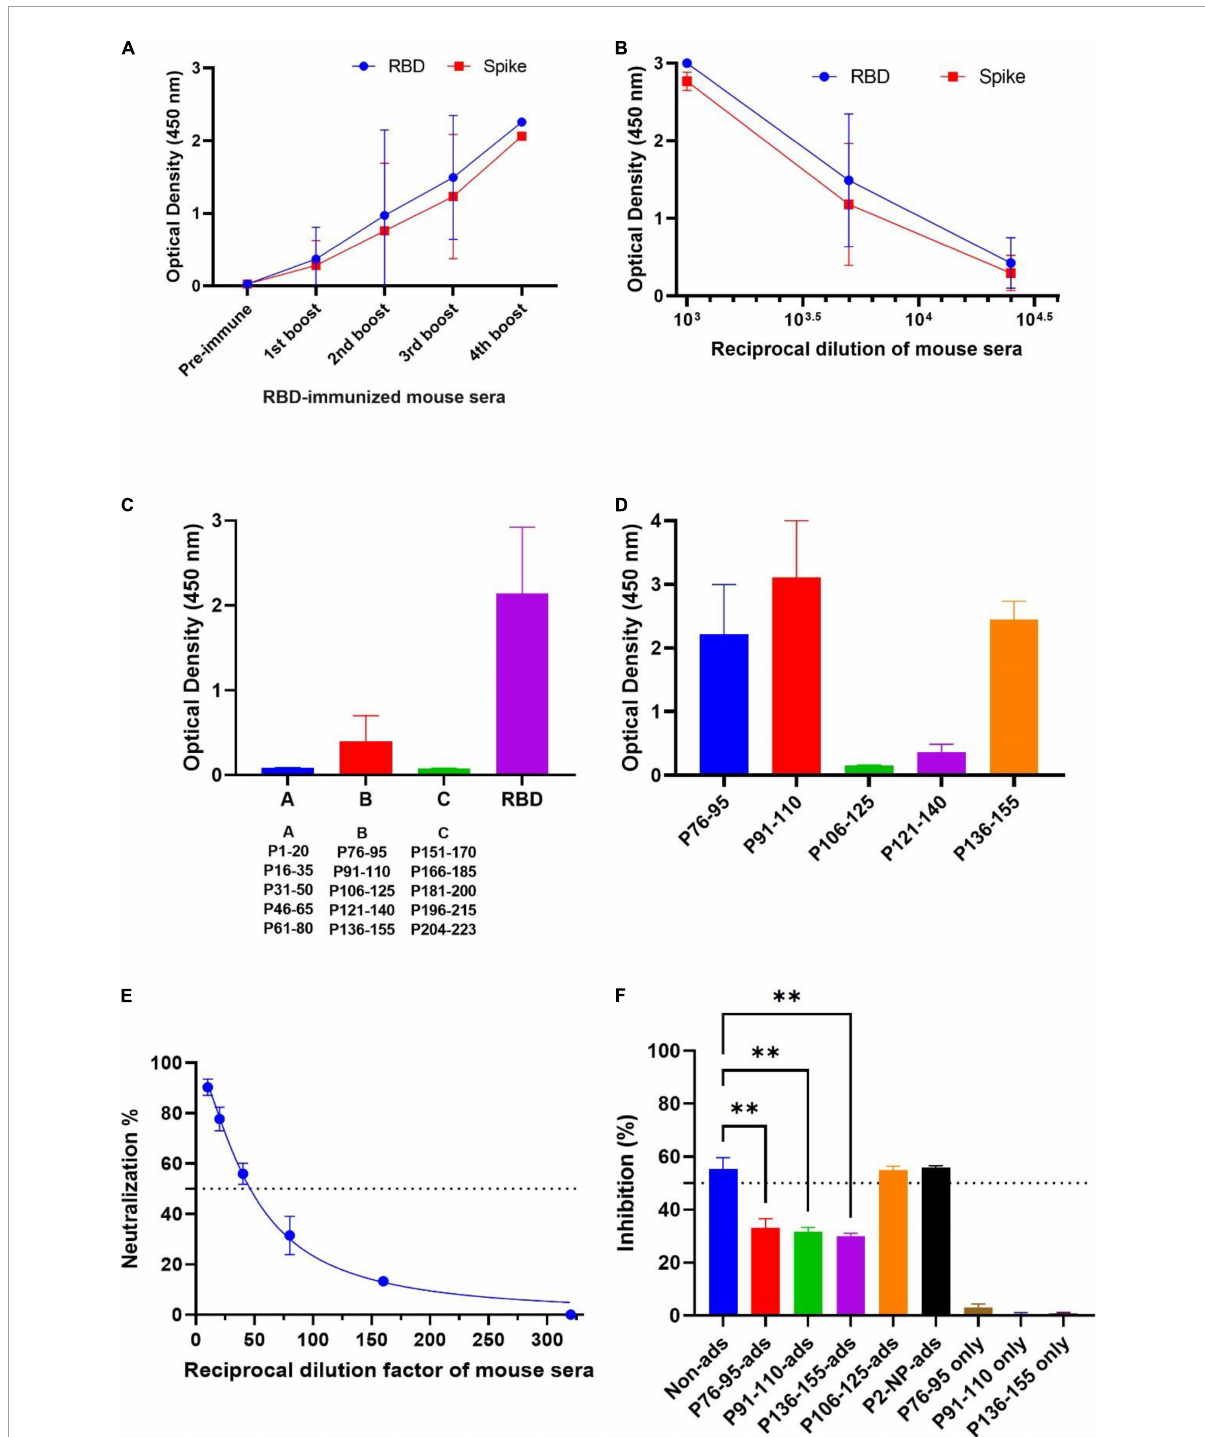
FIGURE2 Antibody responses in the immunized mouse sera against spike, RBD, and linear peptides by ELISA and peptide-adsorption assay by SVNT. (A) Antibody responses against RBD and spike in the immunized mouse sera during the immunization schedule. Sera were tested by ELISA at 1:5,000 dilution. (B) Titration of sera collected from the sacrificed mice before the spleen harvest against RBD and S proteins. (C) The immunodominant epitopes of the SARS-CoV-2 RBD protein were mapped by Pepscan analysis against mouse immunized sera and the immunodominant peptide pool was identified. Mouse hyperimmune sera (1:200) were subjected to three peptide pools (A–C) of overlapping peptides and RBD antigen by ELISA. Each pool contained five 20-mer peptides spanning the entire RBD domain of the spike. (D)